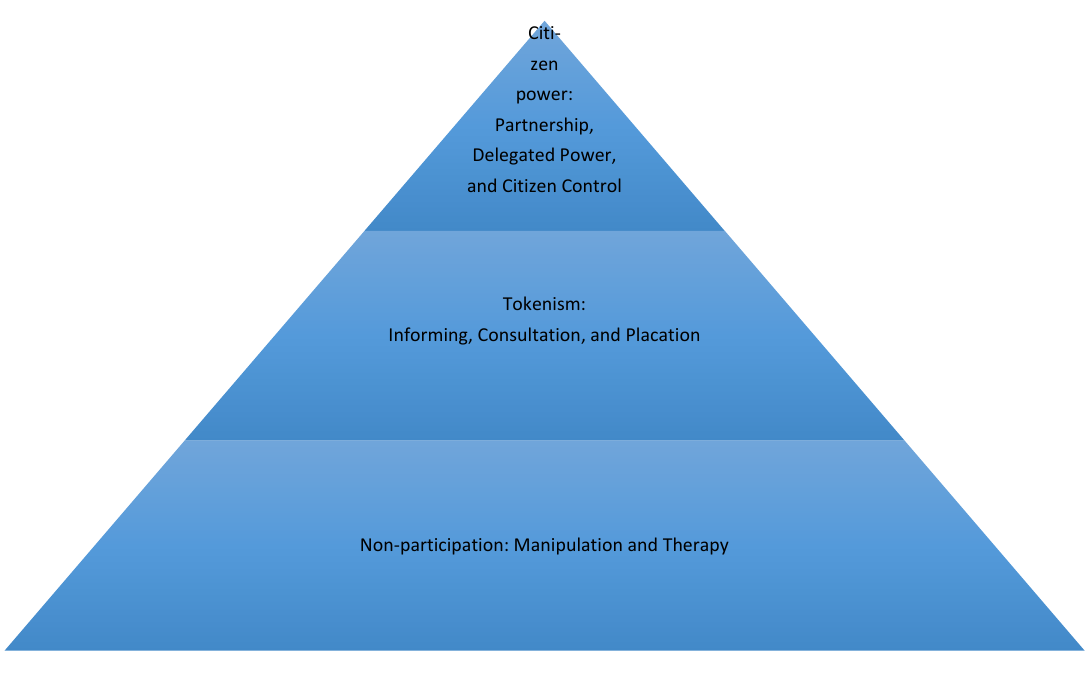
Figure 1. Ladder of participation